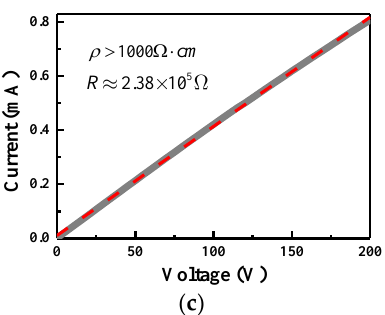
Figure 1. I–V curves of In/n-Si/In devices. ( a ) The schematic measurement configuration. Figure 1. I – V curves of In/n-Si/In devices. ( a ) The schematic measurement configuration. Two- Two-terminal devices In/n-Si/In are fabricated by making indium ohmic contacts on n-doped terminal devices In/n-Si/In are fabricated by making indium ohmic contacts on n-doped monocrystalline silicon with <111> crystallographic orientation. L is the spacing between two electrodes. monocrystalline silicon with <111> crystallographic orientation. L is the spacing between two ( b ) I–V curve of In/n-Si/In device 0129-1# at room temperature with resistance 690 Ω and carrier electrodes. ( b ) I – V curve of In/n-Si/In device 0129-1# at room temperature with resistance 690 Ω and density ~2.1 × 10 14 cm − 3 . L = 2 mm and the applied voltage is in the range from zero to 50 V. V L is carrier density ~2.1 × 10 14 cm − 3 . L = 2 mm and the applied voltage is in the range from zero to 50 V. V L defined as the intersection of the tangent extension cords of the I–V curve in the Ohmic and effective is defined as the intersection of the tangent extension cords of the I – V curve in the Ohmic and trap-filling (ETF) regimes; likewise, V U is the intersection of those in ETF and Mott–Gurney (MG). effective trap-filling (ETF) regimes; likewise, V U is the intersection of those in ETF and Mott – Gurney Thus the Ohm, ETF, and MG regimes are distinguished by two critical voltages. Green, yellow, and red (MG). Thus the Ohm, ETF, and MG regimes are distinguished by two critical voltages. Green, rectangular sections represent Ohm, ETF, and MG regimes respectively. ( c ) I–V curve of In/n-Si/In yellow, and red rectangular sections represent Ohm, ETF, and MG regimes respectively. ( c ) I – V device 0114-1# with L = 5 mm measured at room temperature. The resistance is 2.38 × 10 5 Ω , and the curve of In/n-Si/In device 0114-1# with L = 5 mm measured at room temperature. The resistance is resistivity is larger than 1000 Ω · cm. The applied voltage is in the range from zero to 200 V. Red dash 2.38 × 10 5 Ω , and the resistivity is larger than 1000 Ω∙cm . The applied voltage is in the range from line is the linear fitting to illustrate the linearity of the Ohmic zero to 200 V. Red dash line is the linear fitting to illustrate the linearity of the Ohmic regime.